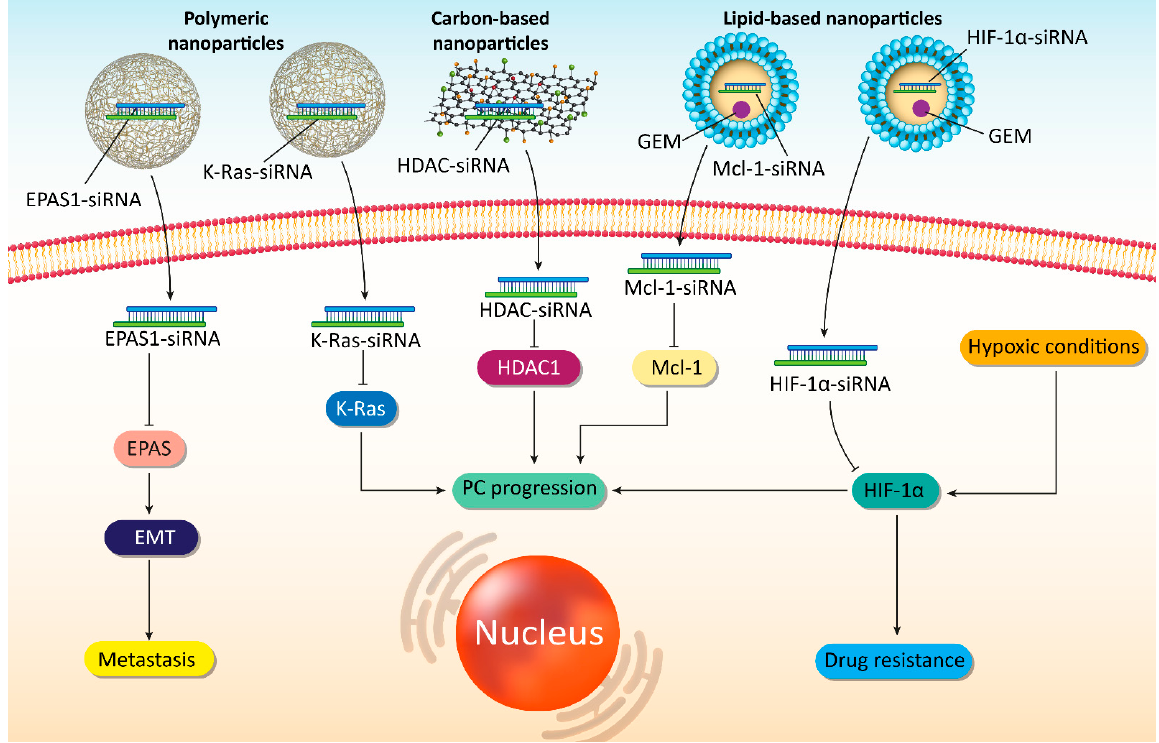
Figure 5. The potential of siRNA-loaded nanoparticles in affecting molecular pathways in PC therapy. Table 3. Co-delivery systems for siRNA in PC therapy.